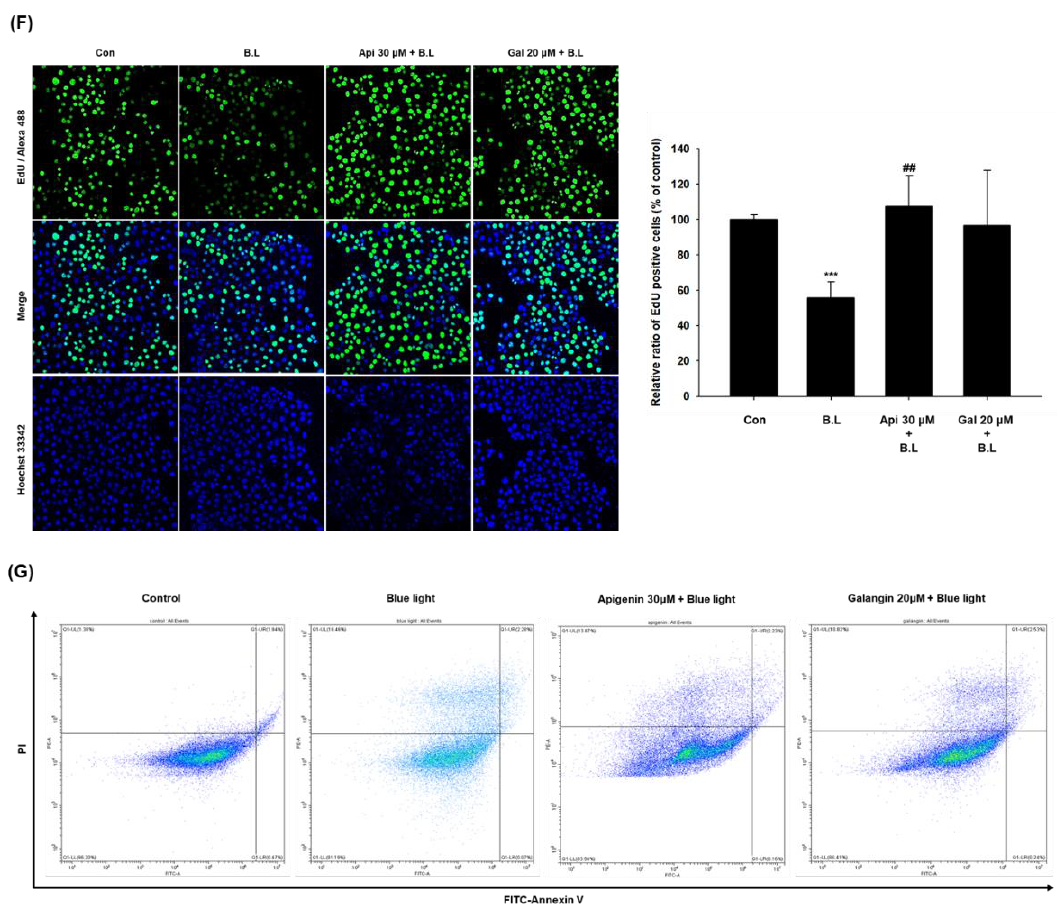
Figure 2. Apigenin and galangin, active components of YCW, increased proliferation in blue light- irradiated HaCaT cells. ( A ) Chemical structure of apigenin, ( B ) and galangin. ( C ) Cell cytotoxicity of apigenin (10–50 µ M) and galangin (1–30 µ M) were measured with CCK-8 assay. The effects of apigenin and galangin on proliferation of blue light (30 min, 76 W/m 2 )-irradiated HaCaT cells were determined by CellTiter-Glo ® 2.0 assay ( D ), BrdU ELISA assay ( E ), and EdU incorporation assay ( F ). Effect of apigenin (30 µ M) or galangin (20 µ M) on blue light-induced apoptosis in HaCaT cells was measured using flow cytometry analysis ( G ) * p < 0.05 vs. control, ** p < 0.01 vs. control, *** p < 0.005 vs. control, # p < 0.05 vs. B.L, ## p < 0.01 vs. B.L, ### p < 0.005 vs. B.L, V: viable cells, D: dead cells.